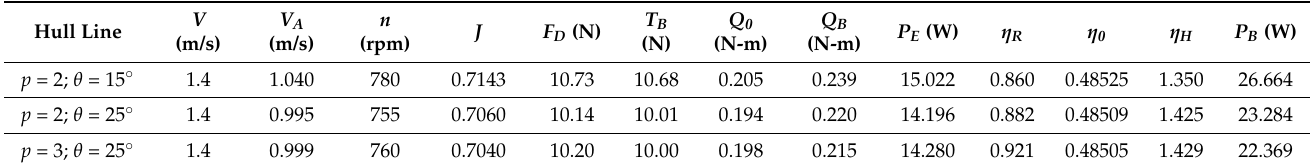
Table 5. The calculation results of the self-propulsion factor of the different hull line AUGs with the CRP.